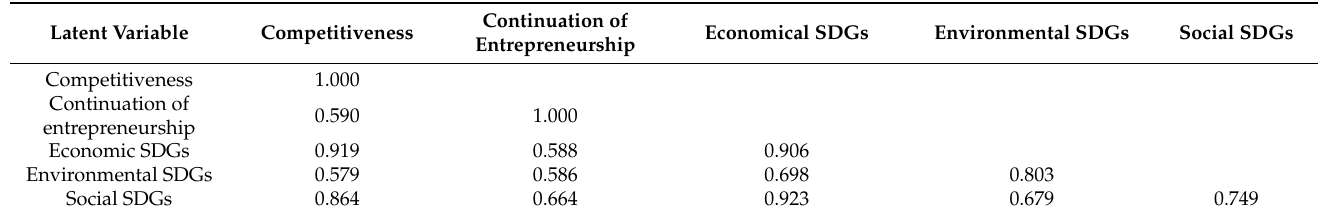
Table 2. Discriminant Validity.